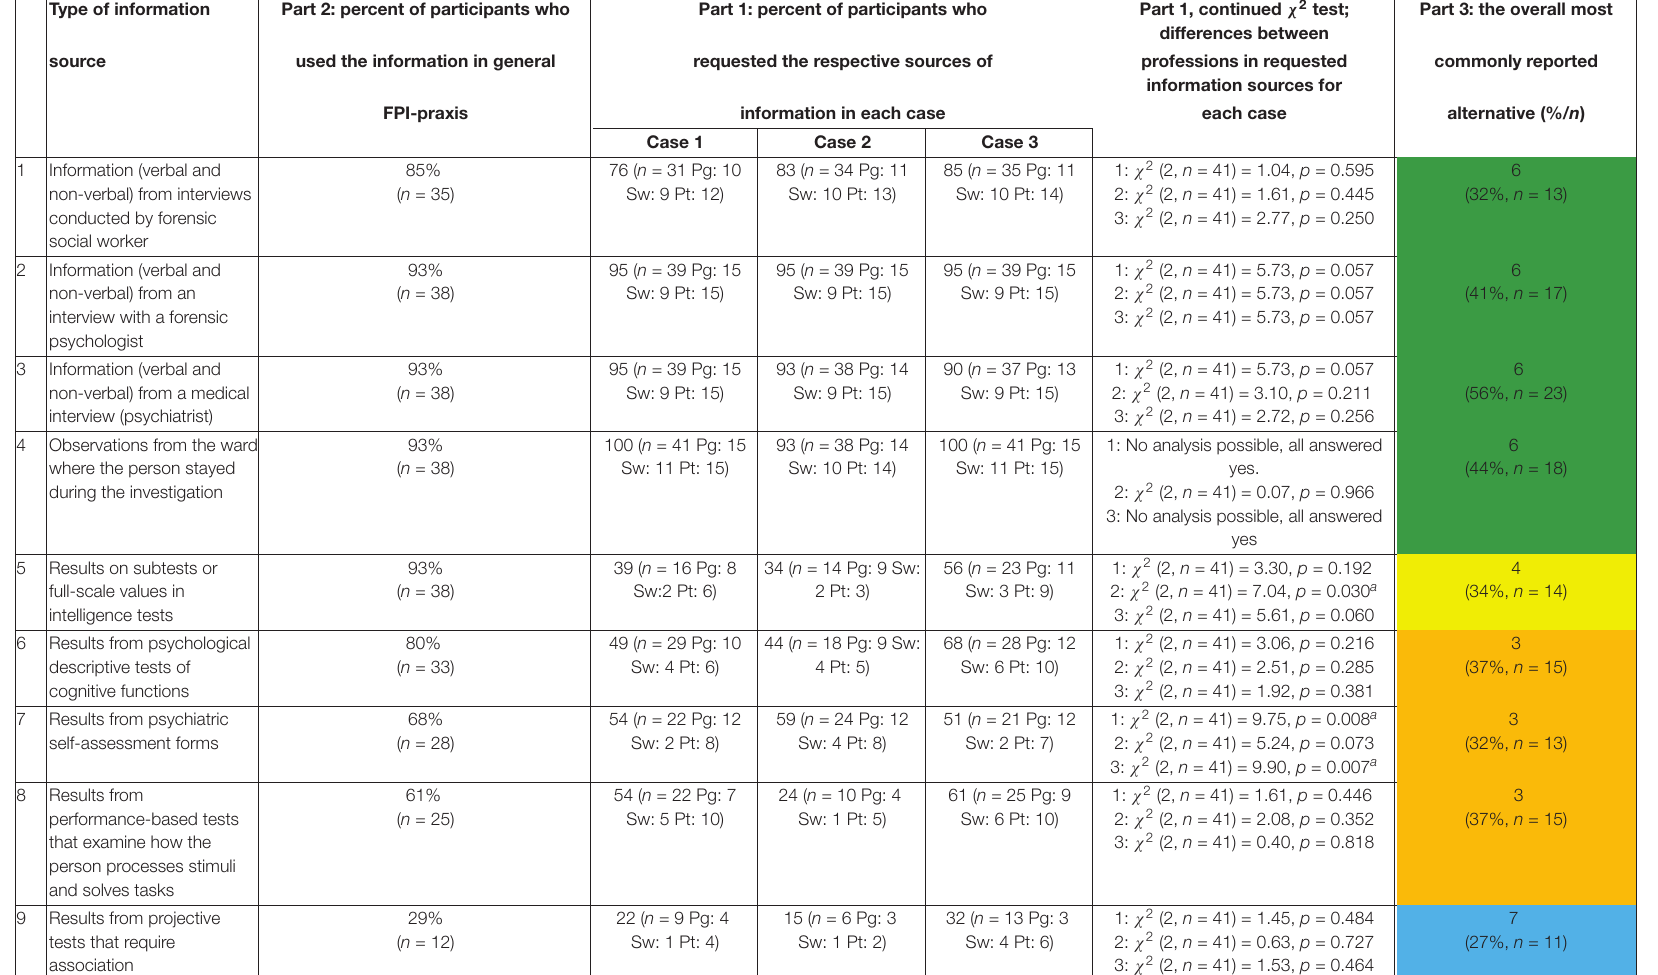
TABLE 1 | The sample’s and the professional groups’ use of information in general FPI-praxis (part 2), in the three cases (part 1), and in their perceived usefulness of the information sources (part